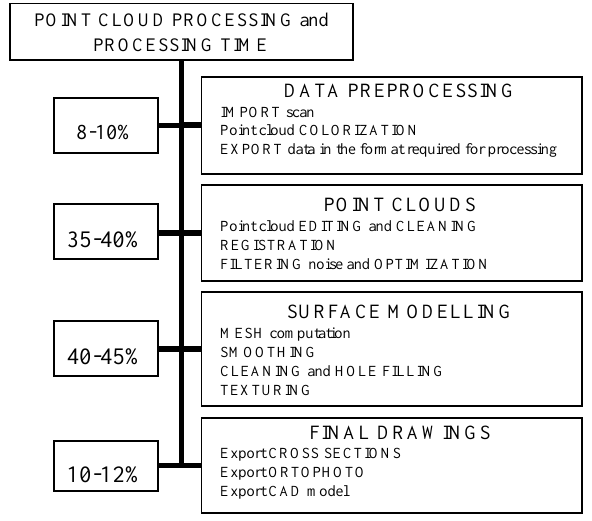
Figure 1. Point cloud processing